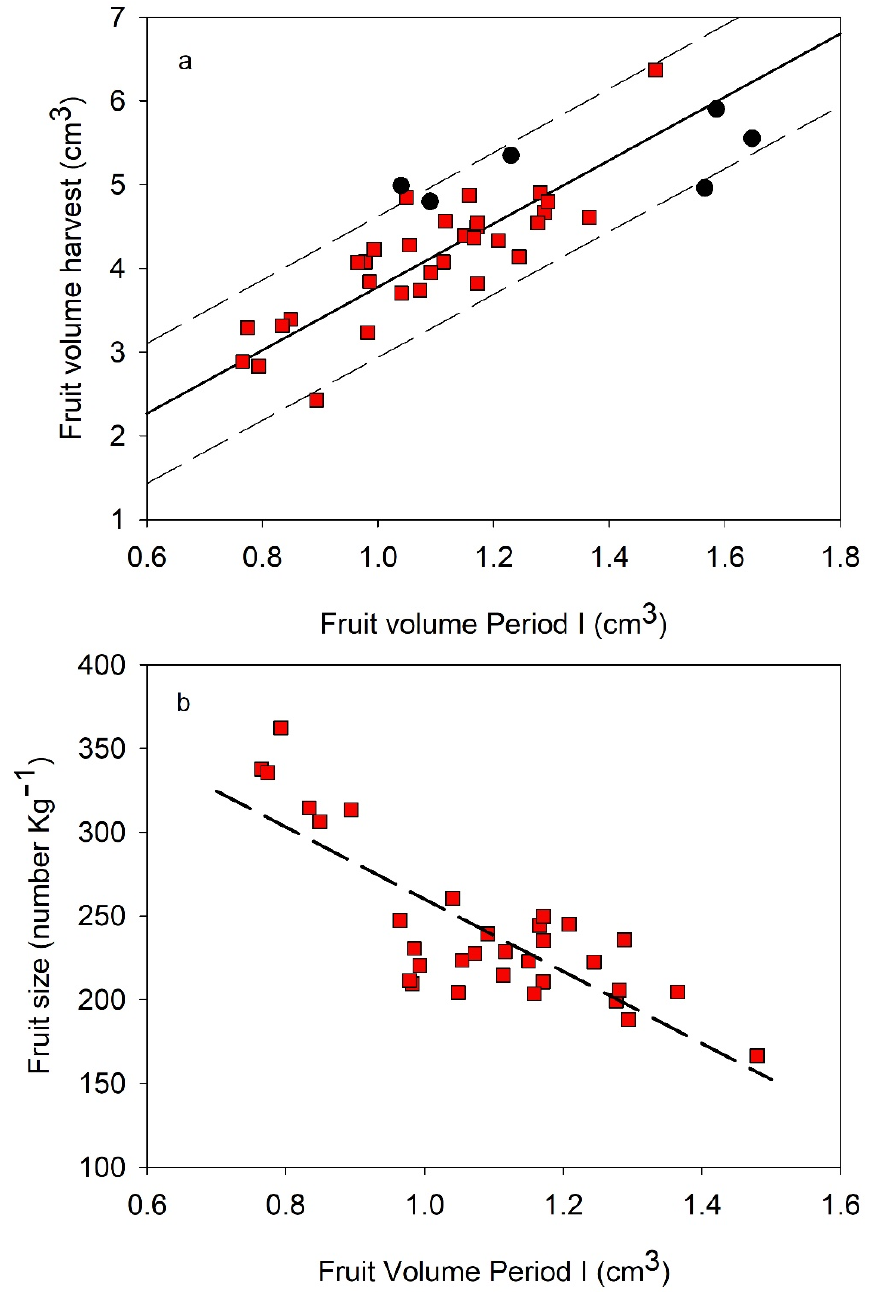
Figure 5. Relationship between fruit volume at Period I of endocarp development and fruit volume at harvest ( a ) and fruit size at harvest ( b ) of published Manzanilla experiments. Lines represent the best fit in both figures (equations at Table 6) and the prediction interval (95% confident) only ( a ). Black symbols at ( a ) are the Manzanilla data of Figure 3. Table 6. Best fits of the relationships between dry weight and volume at Period 1 vs. at harvest in Manzanilla experiments (Figure 5).